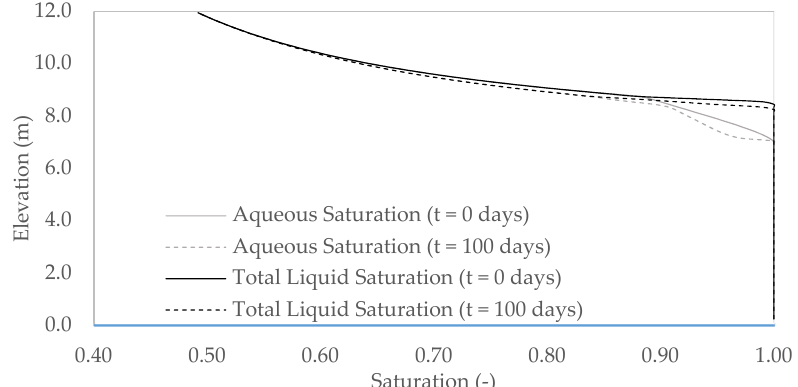
Figure 7. Aqueous and total saturation variation (initial and final) in TE2 under 24.93 kPa for silty